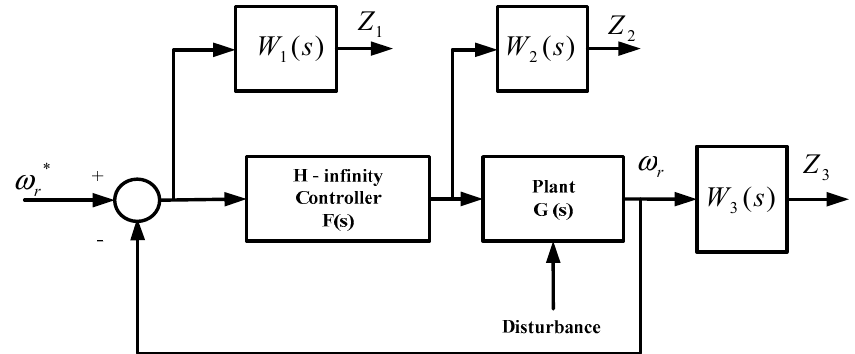
Figure 4. Simplified block diagram of the augmented plant, including the H ∞ controller.